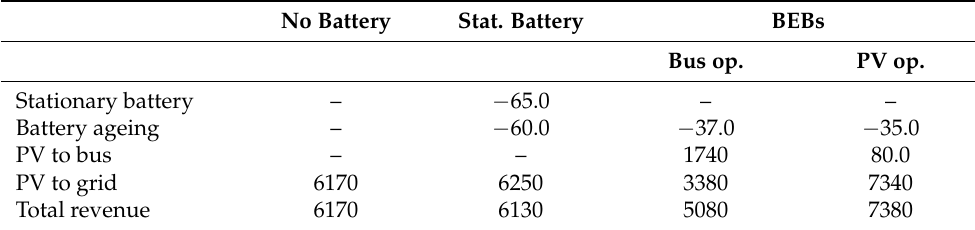
Table 4. Revenue comparison for the PV operator considering no storage, stationary batteries (1% of the installed PV capacity i.e., 13.5kWh), and BEBs (in SGD) for a ramp rate limit of 10% for one week. No Battery Stat. Battery BEBs Bus op. PV op.